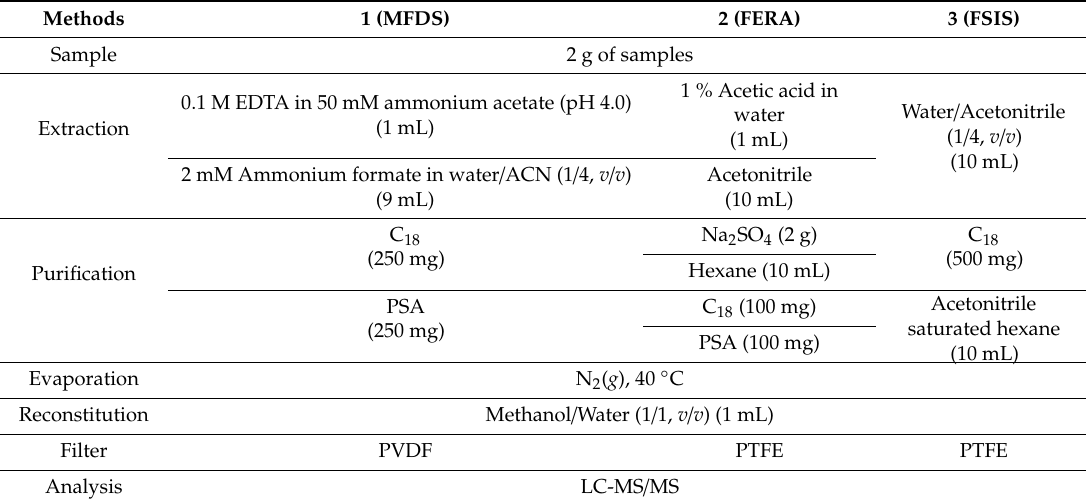
Table 2. Comparison of flow chart for three